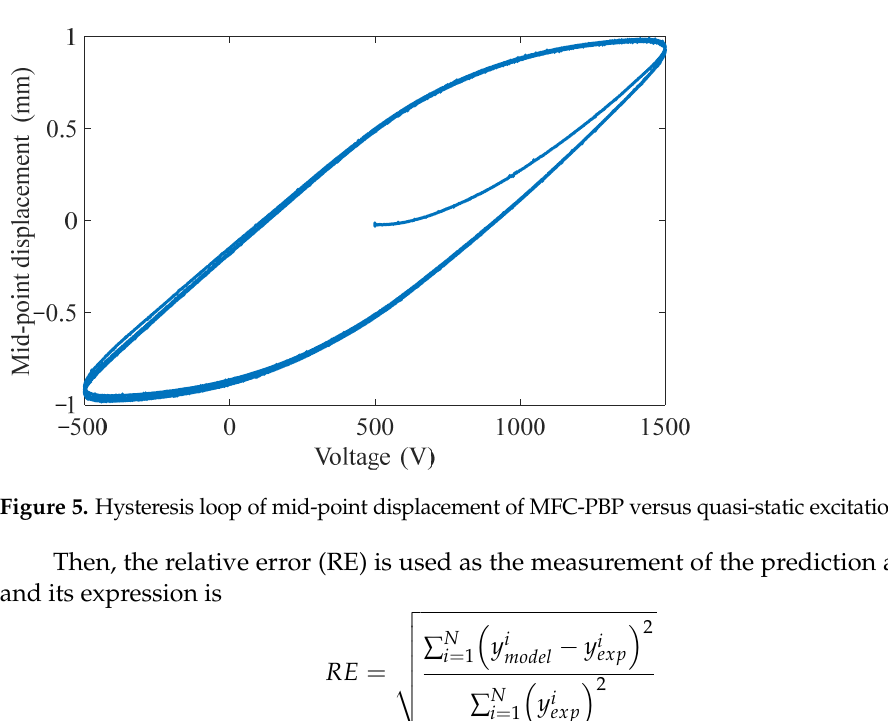
Figure 5. Hysteresis loop of mid-point displacement of MFC-PBP versus quasi-static excitation volt- age.